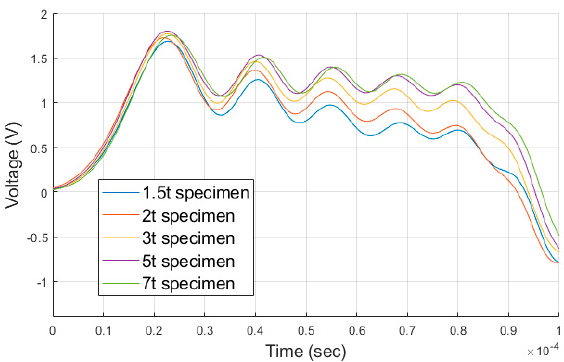
Figure 9. Comparison of the reflected pulse waveforms, measured in the analysis for each thick-